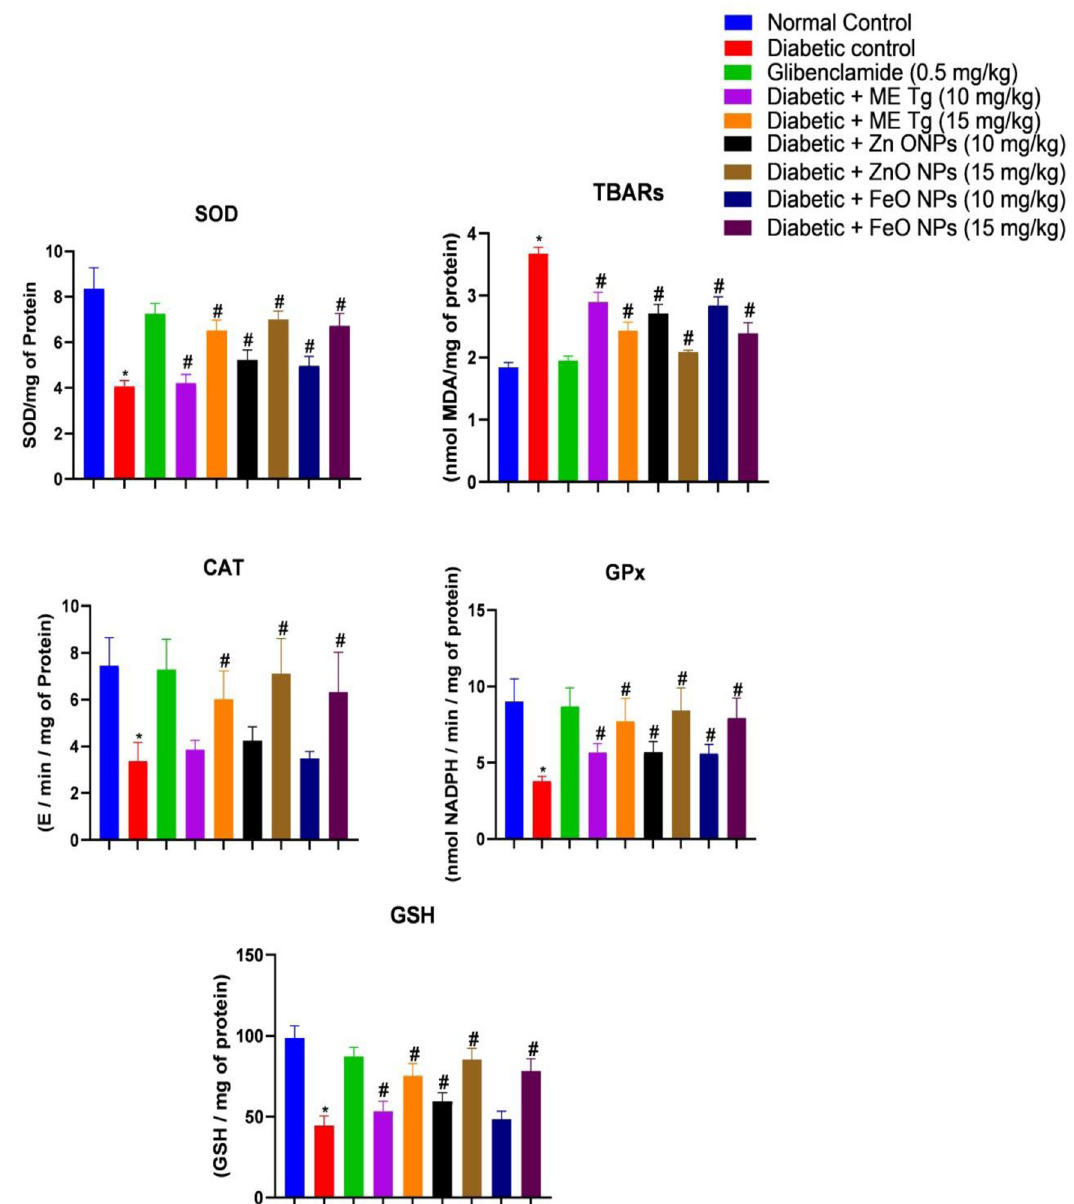
Figure 1: E ff ect of T. glabra methanolic extract and their mediated ZnO NPs and Fe 2 O 3 NPs on the TBARS and SOD, CAT, GPx, and GSH enzyme activities in diabetic rats. * p < 0.05: normal control vs diabetic control; # p < 0.05: diabetic control vs treated groups. METg: methanolic extract of T.